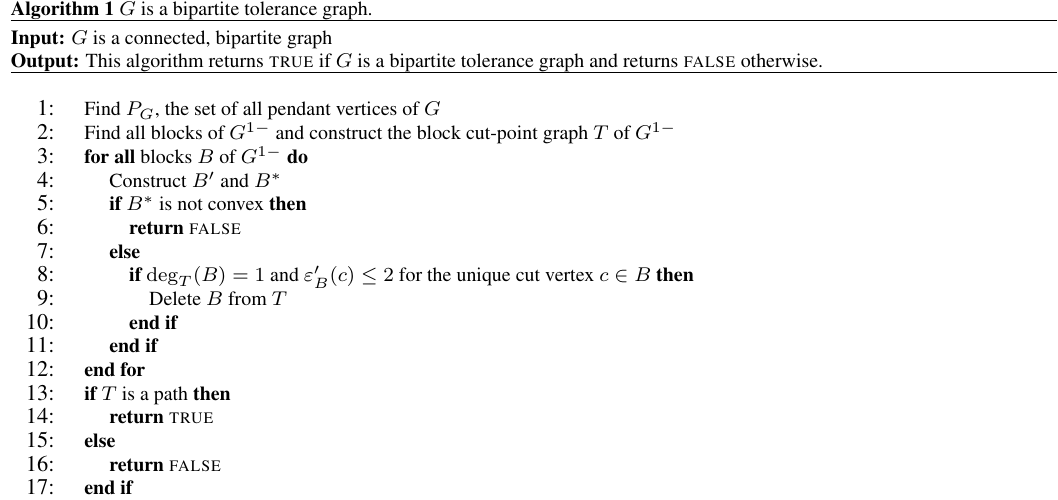
Fig. 4: Algorithm 1: Bipartite tolerance graph recognition